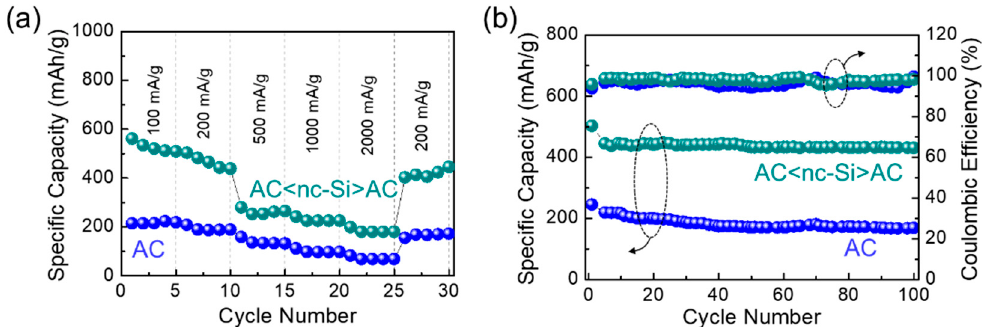
Figure 7. ( a ) Rate performance at various current densities for the LIB devices with the anode materials of AC nanosheets and AC<nc-Si>AC nanocomposites. ( b ) Cycling performance